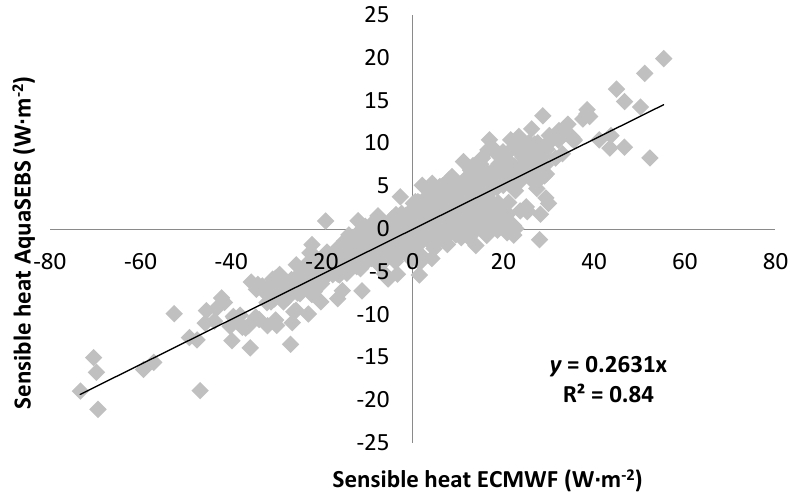
Figure 6. Comparison between the sensible heat (W·m − 2 ) of AquaSEBS and ECMWF models over the Great Salt Lake from January to December 2010.